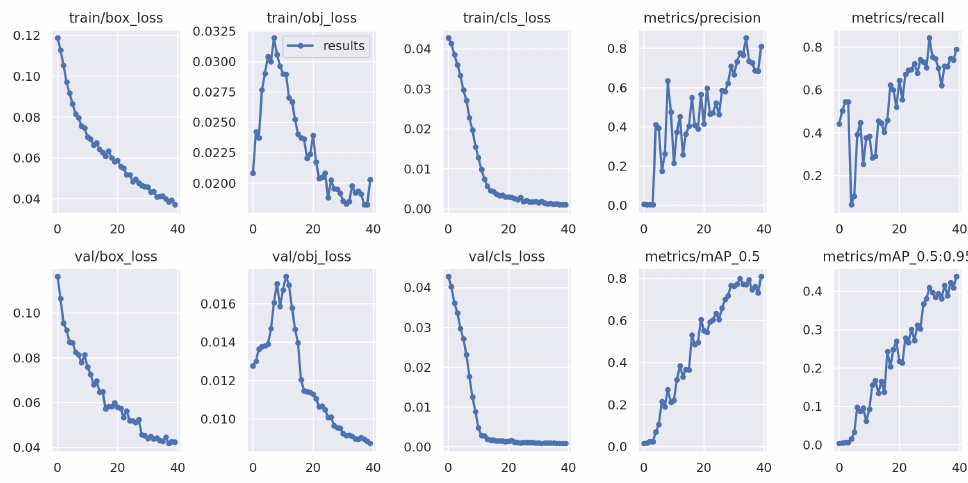
Figure 19. Model evaluation during training on pest pattern and nutrient deficiency classes.